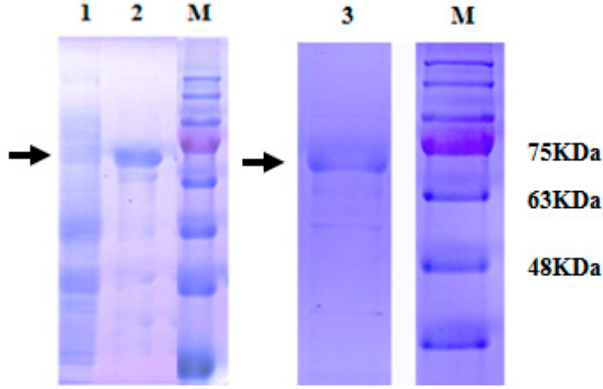
Figure 6. Sodium dodecyl sulfate-polyacrylamide gel electrophoresis (SDS-PAGE) analysis of the